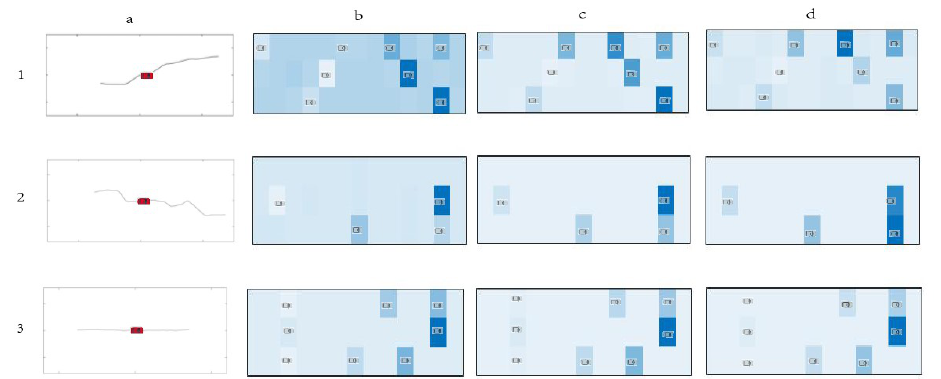
Figure 5. Attention weight distribution under different scenarios. Rows 1, 2, and 3 correspond to three different driving scenarios. Column “a” presents the groundtruth trajectories, while columns “b”, “c”, and “d”, respectively, visualize the attention distribution of 1 s, 3 s, and 5 s in the